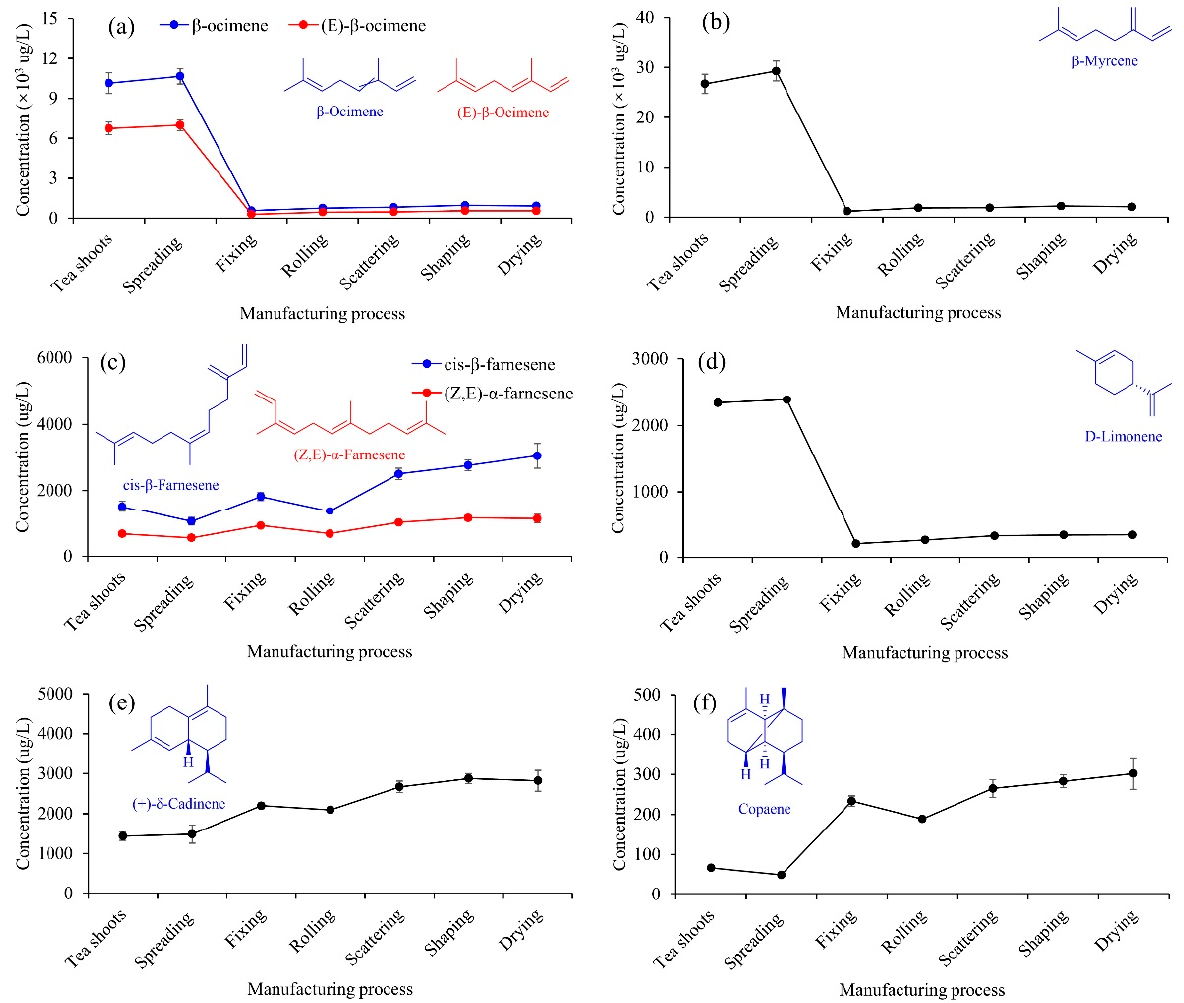
Figure 6. Changes in the concentrations of β -ocimene and (E)- β -ocimene ( a ), β -myrcene ( b ), cis- β - farnesene and (Z,E)- α -farnesene ( c ), D-limonene ( d ), (+)- δ -cadinene ( e ) and copaene ( f ).